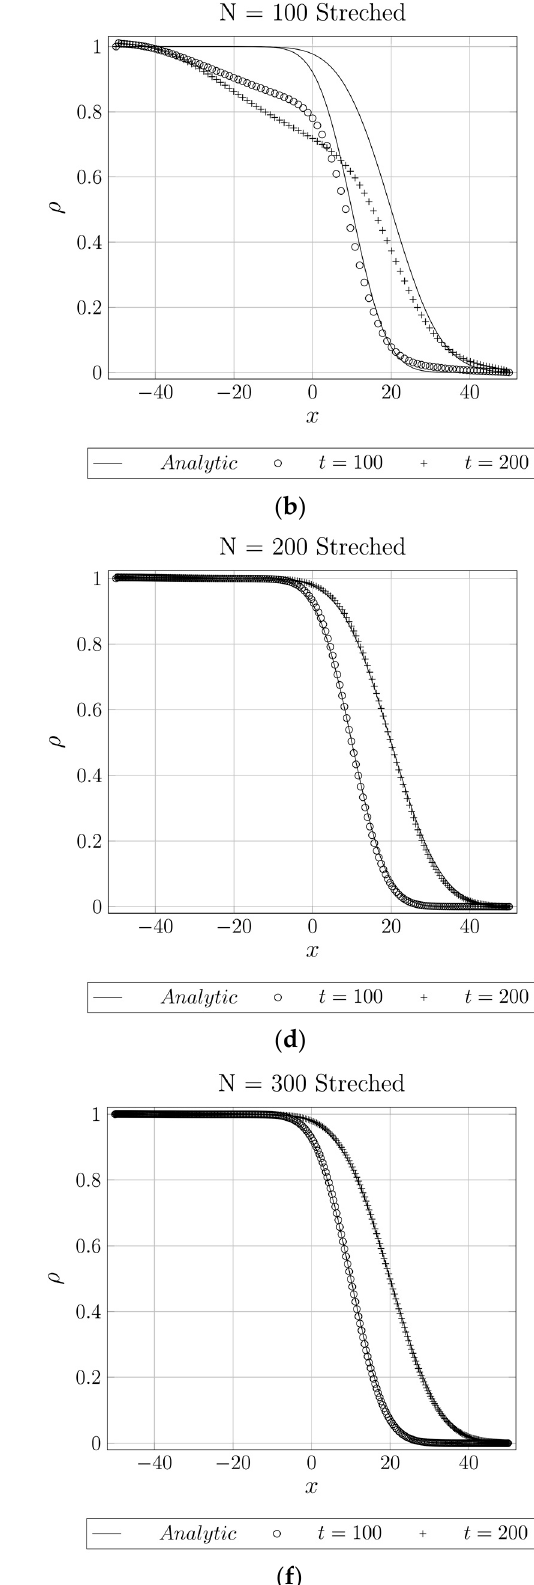
Figure 5. Advection–diffusion problem solved by LBM and RBF interpolation. ( a , c , e ) have a uniform mesh with 100, 200, and 300 points, respectively, while ( b , d , f ) have a stretched mesh with 100, 200, and 300 points, respectively.